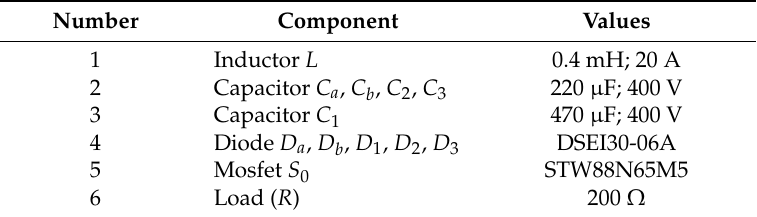
Table 6. Accessories used for experiments.